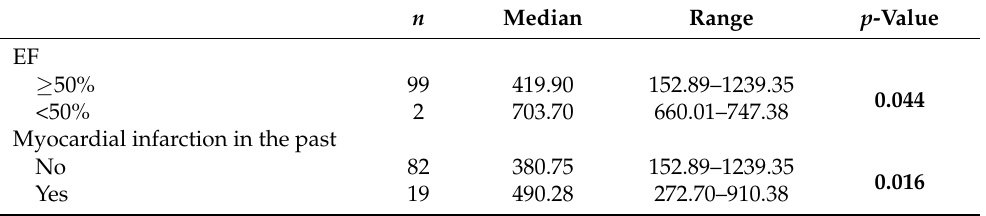
Table 3. OPG concentrations in the groups divided according to EF: the presence of myocardial infarction in the past, the thickness of IVS, the size of LA, relaxation, the E/E’ value, TAPSE and